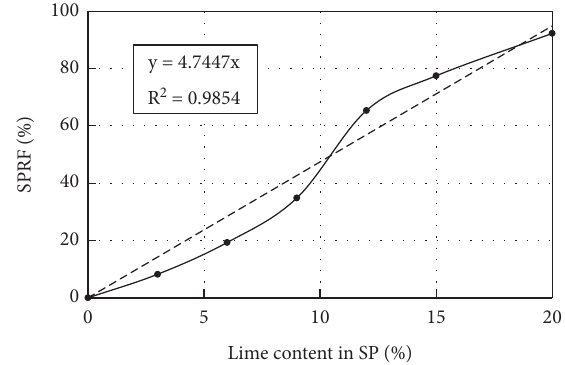
Figure 8: Swelling potential reduction factor versus lime content in SP (RAR �